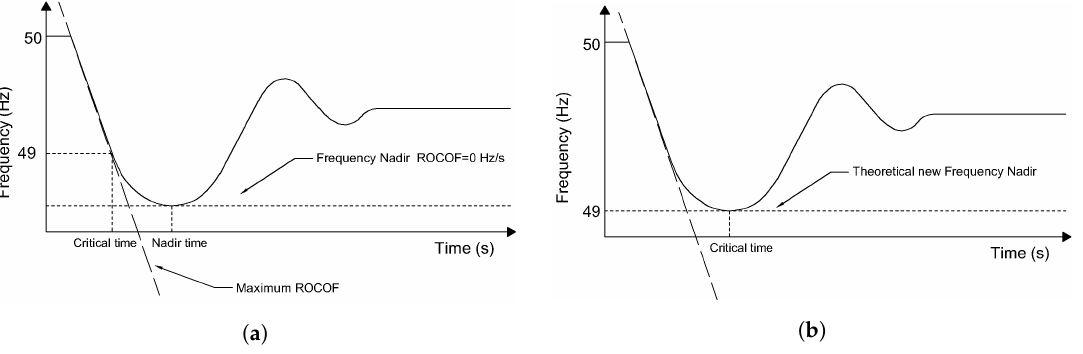
Figure 2. ( a ) Typical frequency response after a power imbalance leading to under-frequency load shedding (UFLS) at the critical time. ( b ) Power response with IBFPR applied to compensate power